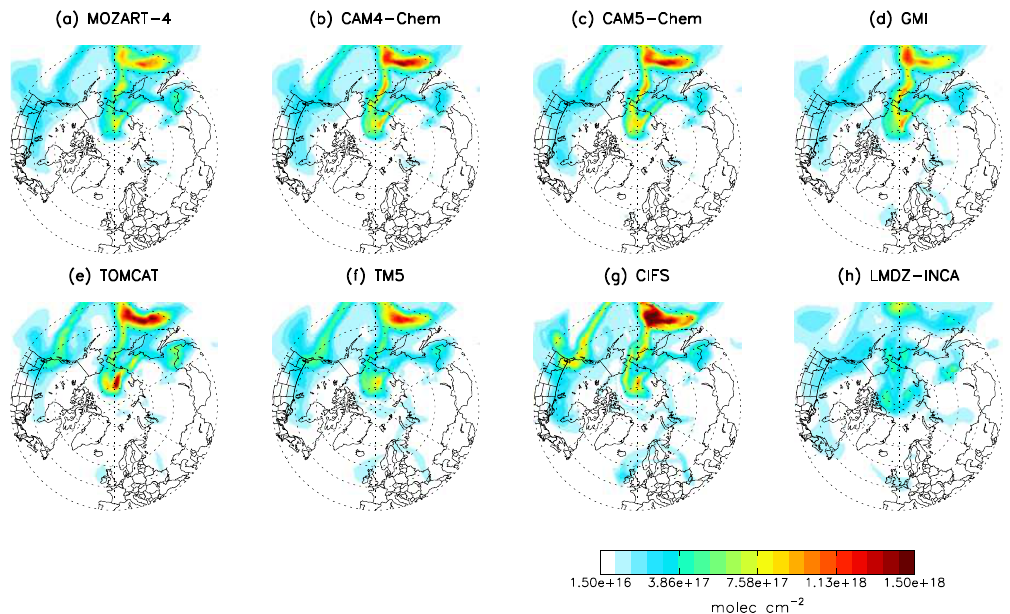
Figure 11. Total column concentrations of the 25-day fixed-lifetime Asian fire tracer from the POLMIP model simulations at 06:00UT on 7 July 2008. Table 2. Positions and chemical composition of fire plume maxima in the POLMIP model simulations at 06:00UT on 7 July 2008. Plume maxima positions are defined based on abundance of simulated 25 day fixed-lifetime Asian biomass burning tracer. See text for